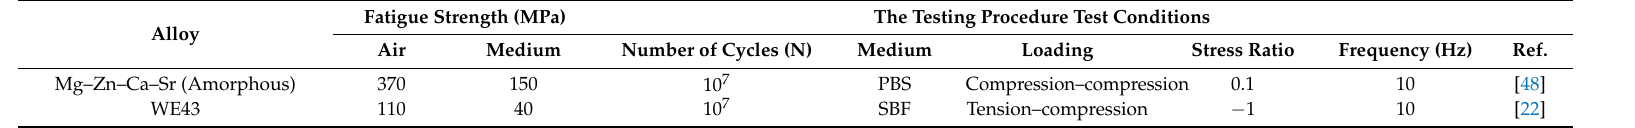
Table 4. Comparison of the fatigue resistance of amorphous Mg–Zn–Ca–Sr alloy and crystalline WE43